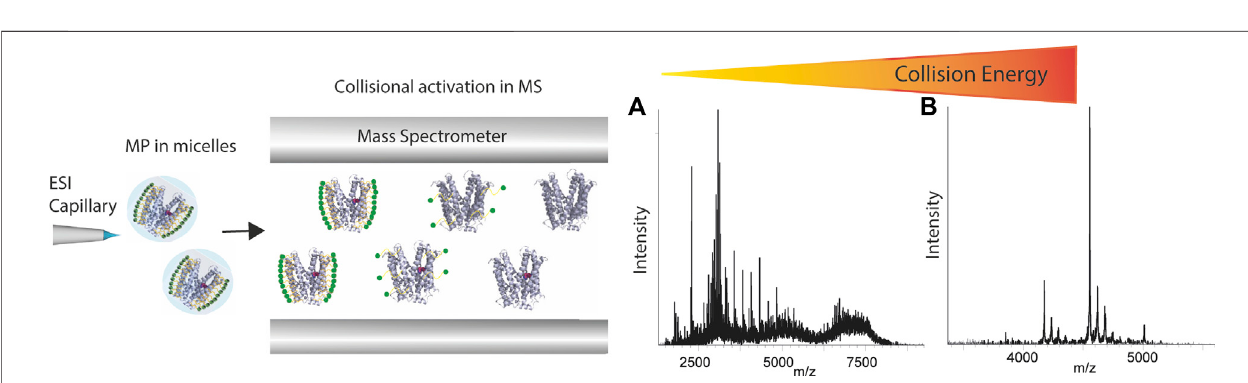
FIGURE 4 | Competition experiments. (A) Both the ligand (L) and the hot ligand (HL) bind at the same binding site. When the concentration of the hot ligand increases,theprotein-ligandpeakeventuallydisappears. (B) Theligandandthehotliganddonotbindatthesamebindingsite.Whentheconcentrationofthehotligand increasesandtheproteingetssaturated,theprotein-ligandpeakeventuallydisappears,andanewpeakappears,correspondingtotheproteinwithbothligandsbound.